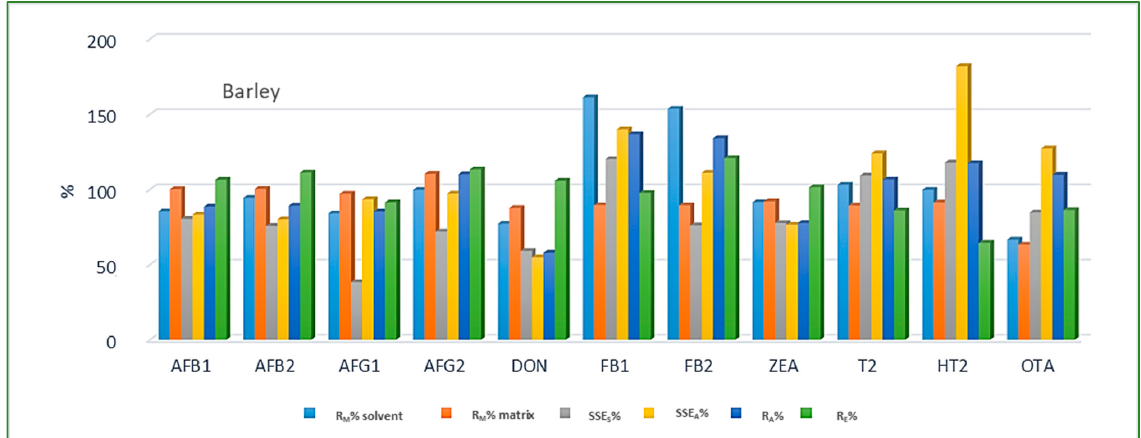
Figure 5. Method recovery (R M ), matrix effect (SSE S -slope, SSE A -area), apparent recovery (R A ) and extraction efficiency (R E ) in barley.